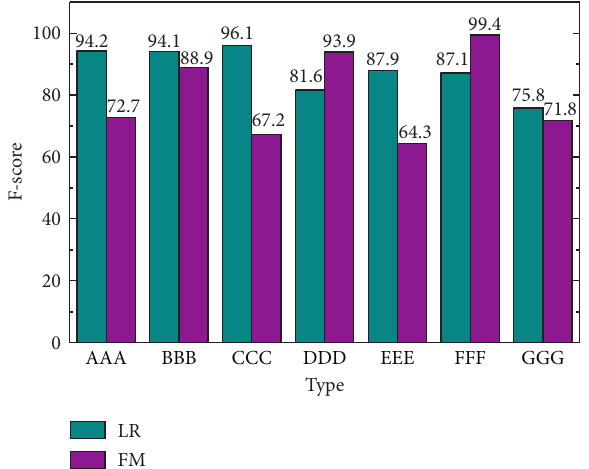
Figure 8: Comparison of the recommendation effect of pair-rate regression and factor